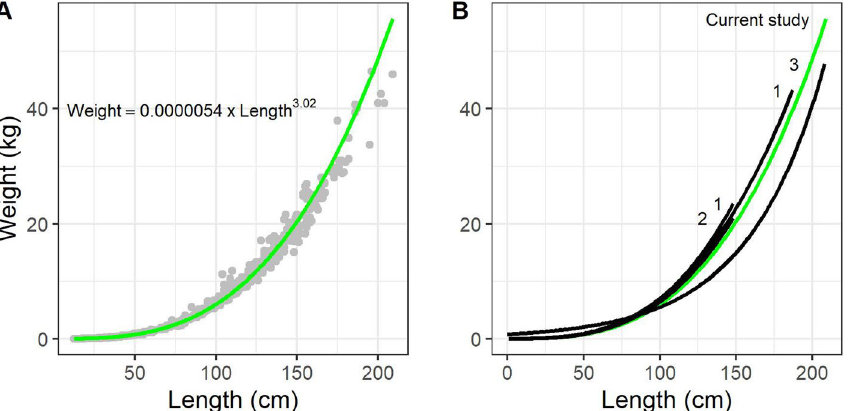
Figure 4. Weight-length relationship for catfish. ( A ) The focal northern peripheral populations. ( B ) Comparison of current study in green with three other reported weight-length relationships from native populations in the core distribution area (1 23 , 2 53 , 3 22